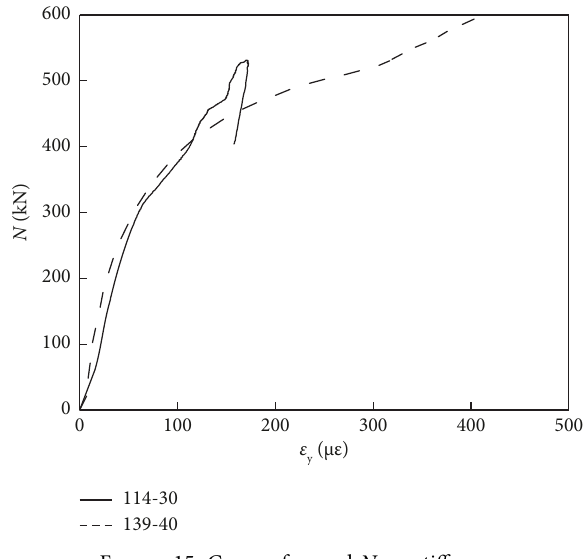
y and N on stifener.